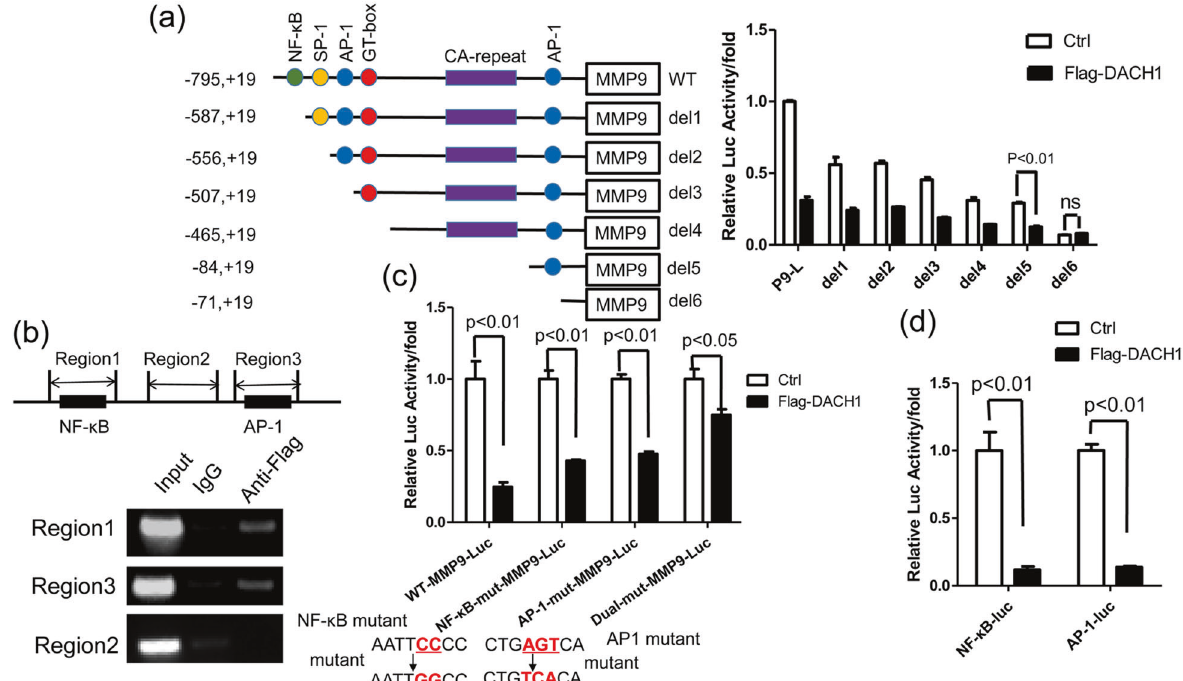
Fig. 3 Determination of DACH1 binding sites in MMP9 promoter. a HEK 293 T cells were transfected with a series of 5 ’ -deletion constructs of human MMP9 promoter-reporter plasmids together with or without Flag-DACH1. After 24 h, the luciferase activities were measured. The bar graph shows the fold changes in relative luciferase activity normalized against the β -galactosidase activity. There were three independent experiments with three parallel wells each. b ChIP assay showing the binding region of DACH1 in MMP9 promoter. Up, PCR ampli fi ed region of MMP9 promoter. Down, HEK 293 T cells were transfected with Flag-DACH1. Cross-linked chromatin was extracted from the cells and subjected to immunoprecipitation with anti-Flag antibody. The DNA regions were ampli fi ed by PCR. IgG was used as a negative control. c HEK 293 T cells were transfected with WT-MMP9-luc, NF- κ B mut-MMP9-luc, AP-1 mut-MMP9-luc or dual-mut-MMP9-luc together with or without Flag-DACH1. Luciferase activity was measured 24 h after transfection. HEK 293 T cells were transfected with pNF- κ B-Luc or pAP-1-luc along with or